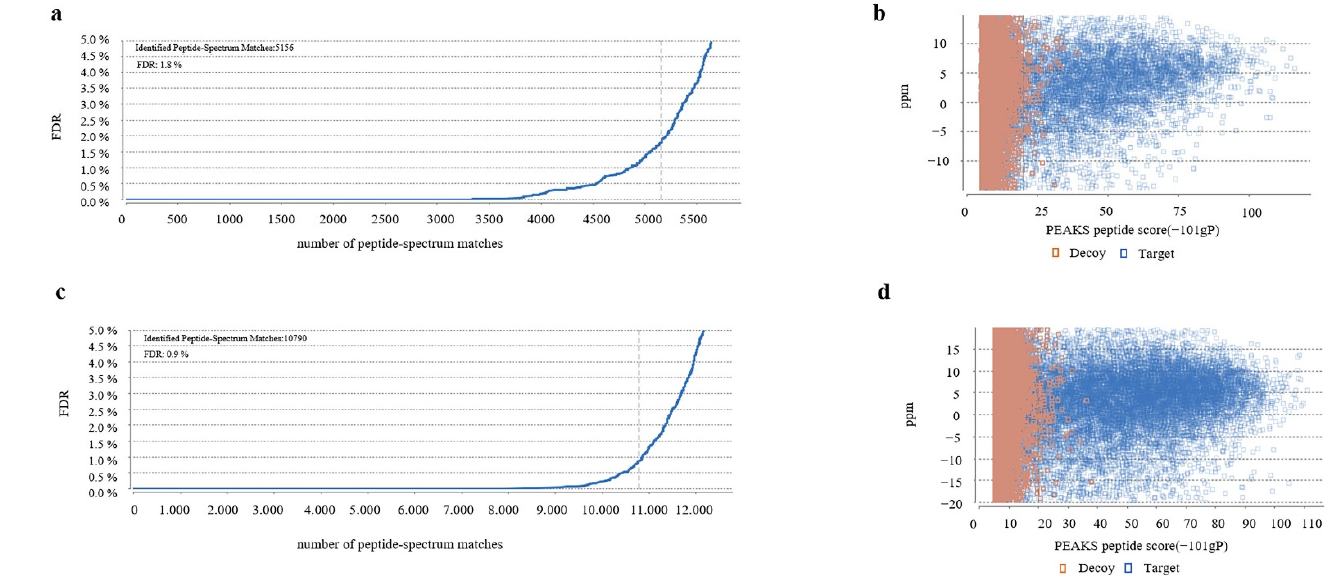
Figure 5. LC -MS/MS analysis of BmN sample and silkworm sample. ( a ) The number of peptide- spectrum matches of the BmN sample. ( b ) PEAKS peptide score of BmN sample. ( c ) The number of peptide-spectrum matches of silkworm sample. ( d ) PEAKS peptide score of silkworm sample.